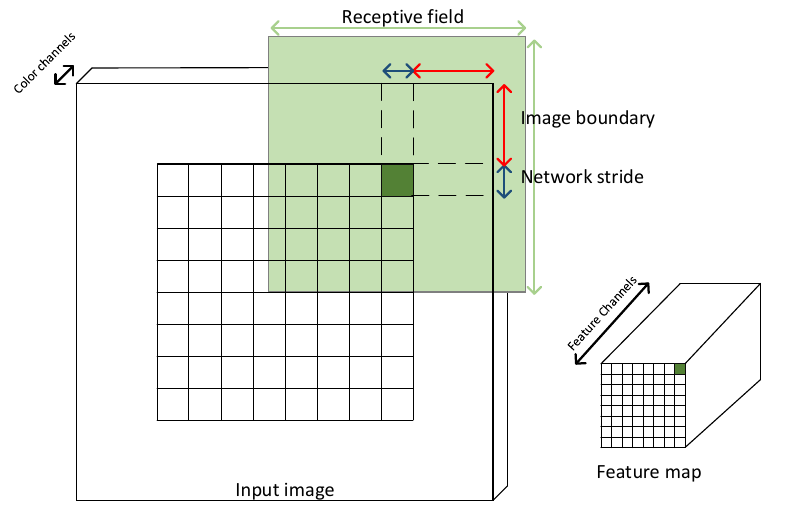
Figure 7. Mapping of a feature map entry (marked with dark green) back to the input image. A feature map entry describes an area of similar size as the network stride in the input image. A feature is determined by the information captured in the receptive field. Image boundary areas are not explicitly described by a feature map entry; only implicitly by the receptive field of nearby feature map